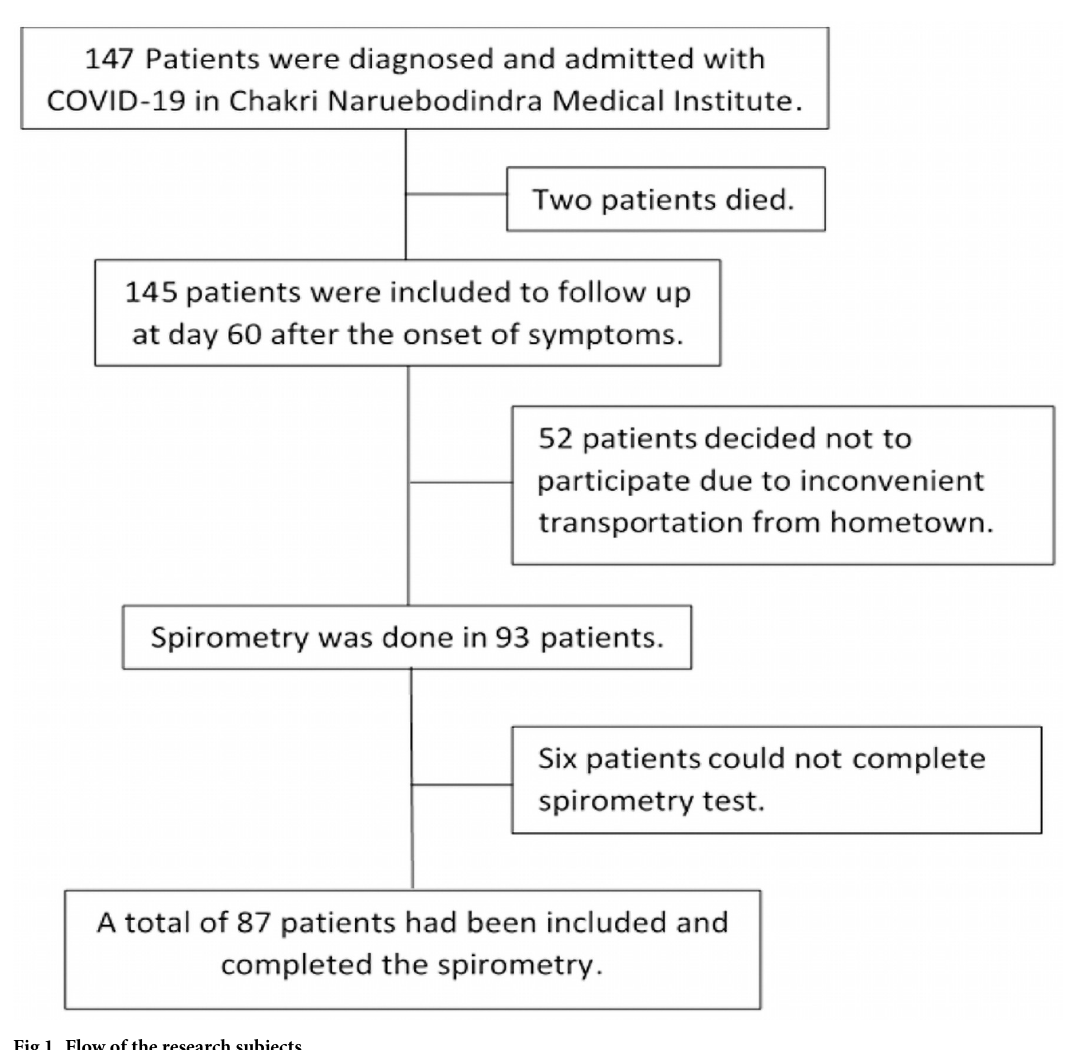
Fig 1. Flow of the research